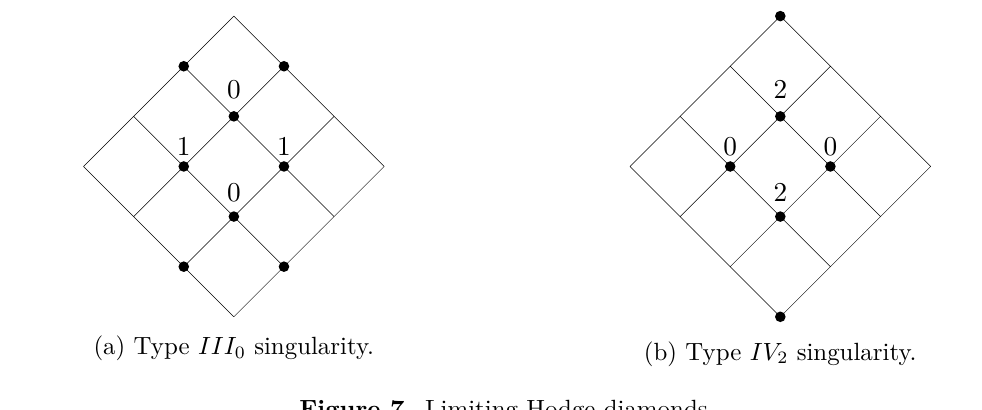
Figure 7. Limiting Hodge diamonds.